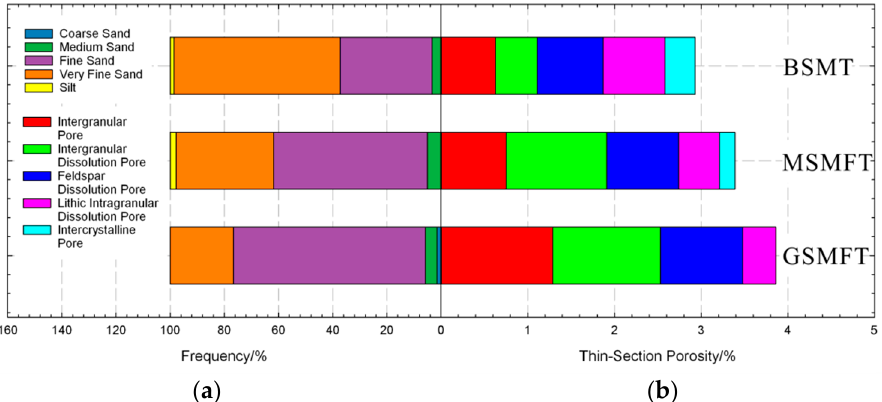
Figure 8. ( a ) Grain size and ( b ) pore types distribution of three pore-throat structure types obtained from thin section analysis.